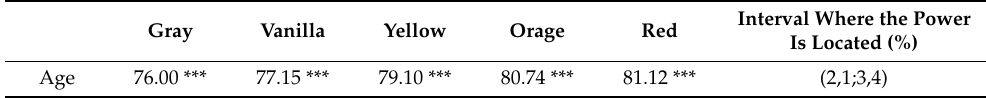
Table 10. Age of persons over 65 years of age living alone based on the color of the patient AMG triangle in Drago-EHRPC. Basic Health Areas of Gran Canaria. 2018–2020. Medians. Interval Where the Power Gray Vanilla Yellow Orage Red Is Located (%) Age 76.00 *** 77.15 *** 79.10 *** 80.74 ***